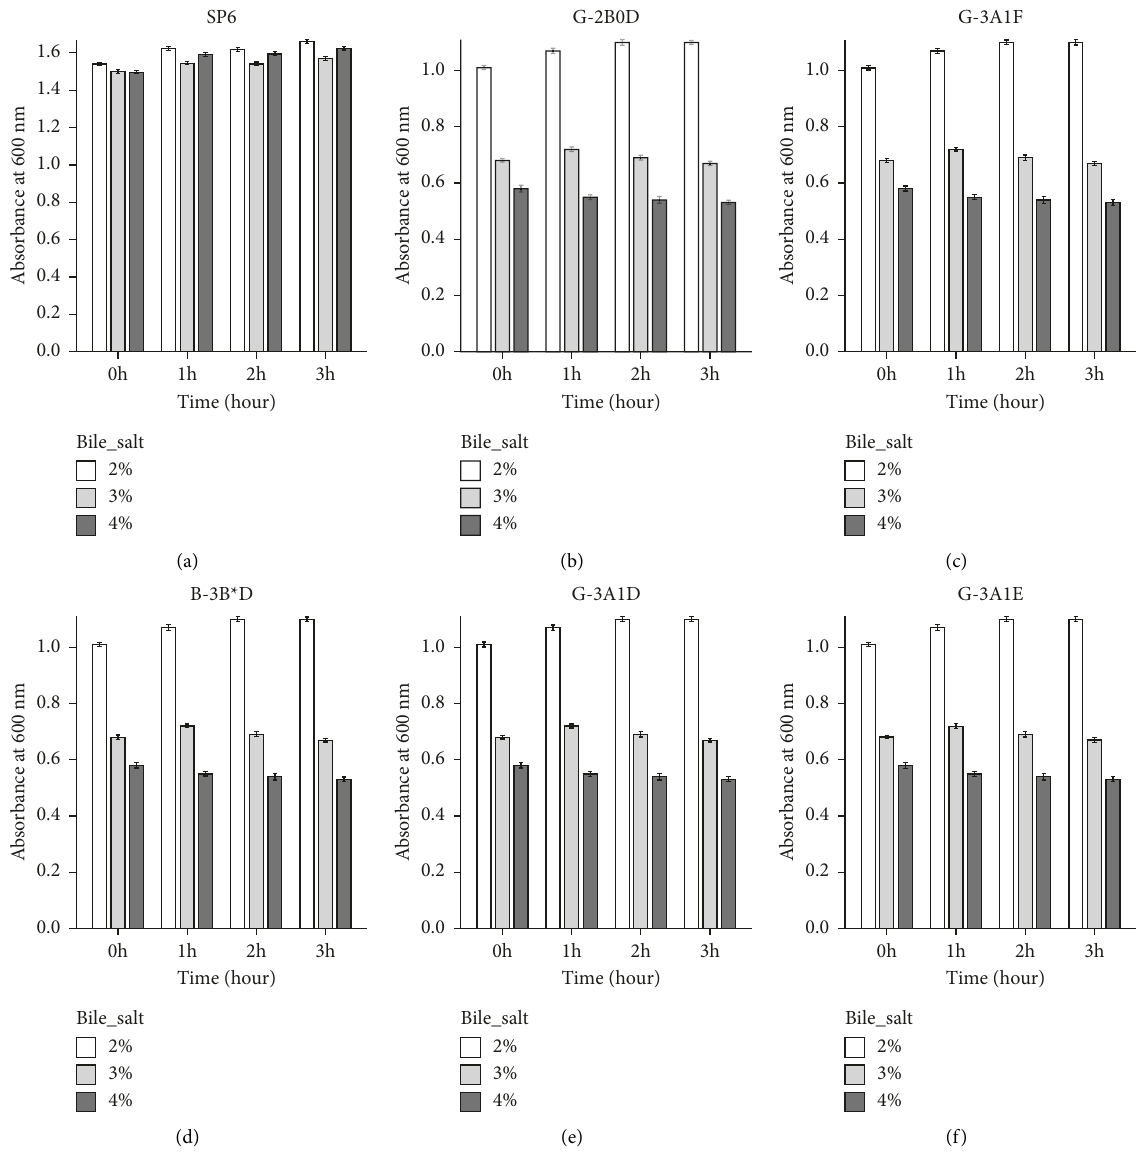
Figure 2: Growth rates of Salmonella typhimurium strains (a) SP6, (b) G-2B0D, (c) G-3A1F and Salmonella enteritidis strains (d) B–3B (e) G-3A1D, and (f) G-3A1E in bile salt. The bars represent the standard deviation of the mean. The graph is generated in